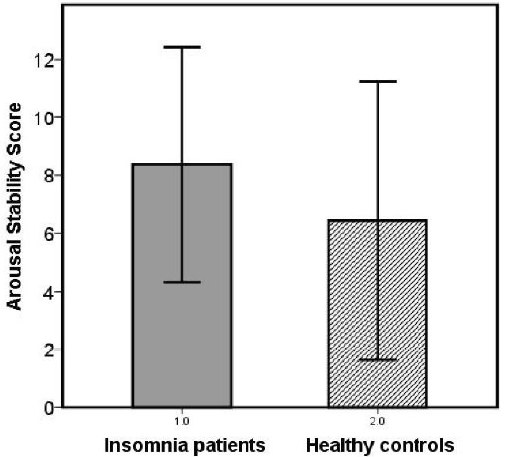
Figure 1. Arousal stability scores in patients with insomnia disorder and healthy control subjects.